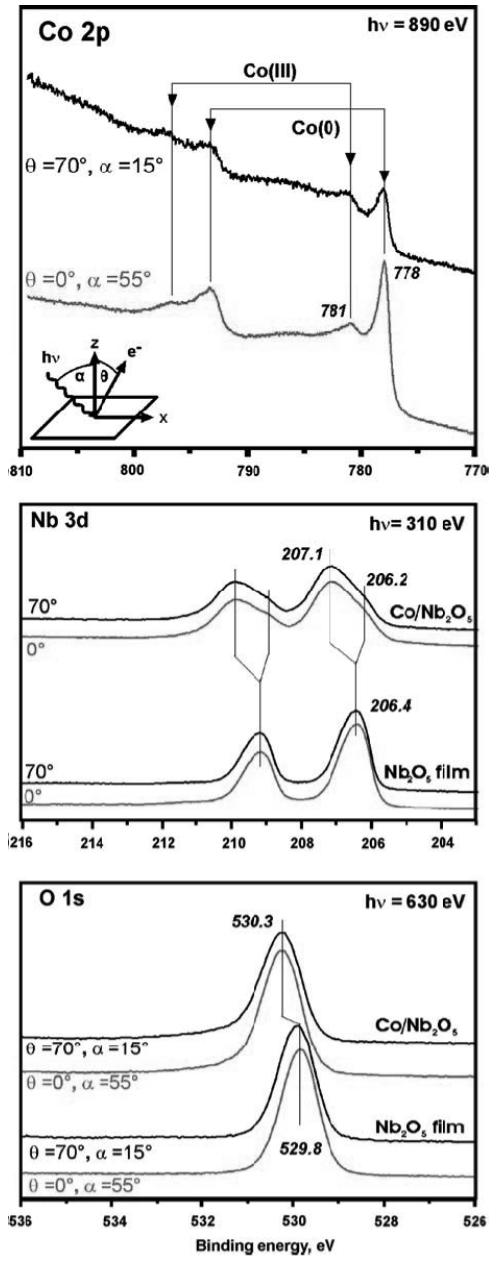
Fig. 20 – Co2p, Nb3d and O1s regions of photoelectron spectra mea- sured at two different geometries as depicted in the inset. The spectra for Nb and O core levels are shown before and after 2Å of Co have been deposited at 300 K (Mendes et al.